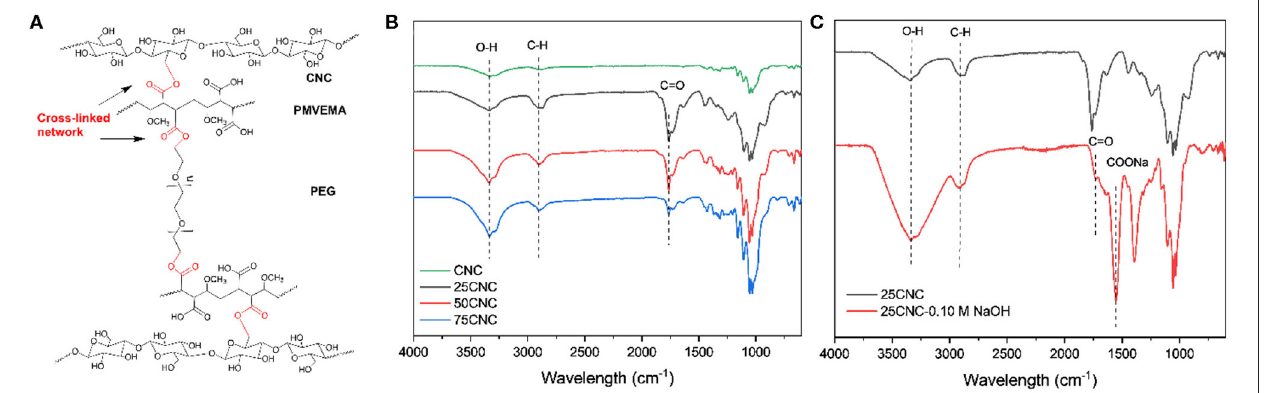
FIGURE 1 | (A) Scheme of the possible structure of thermal treated cross-linked CNC aerogels. (B) FT-IR spectra of CNC aerogels. (C) FT-IR spectra of NaOH treated and un-treated 25CNC aerogels.